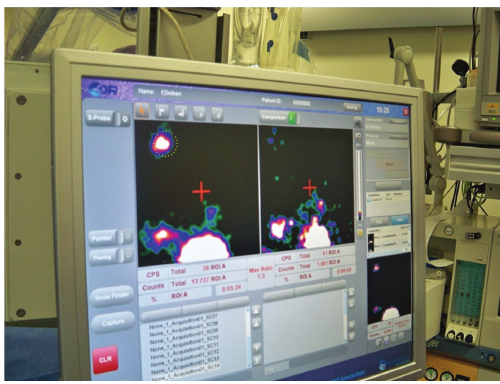
Figure 1: Combined intraoperative surgical guidance using the portable gamma camera and the laparoscopic gamma probe. On the screen, the iodine seed on the tip of the probe is represented by a circle, before (left) and after (right) excision of an SN.